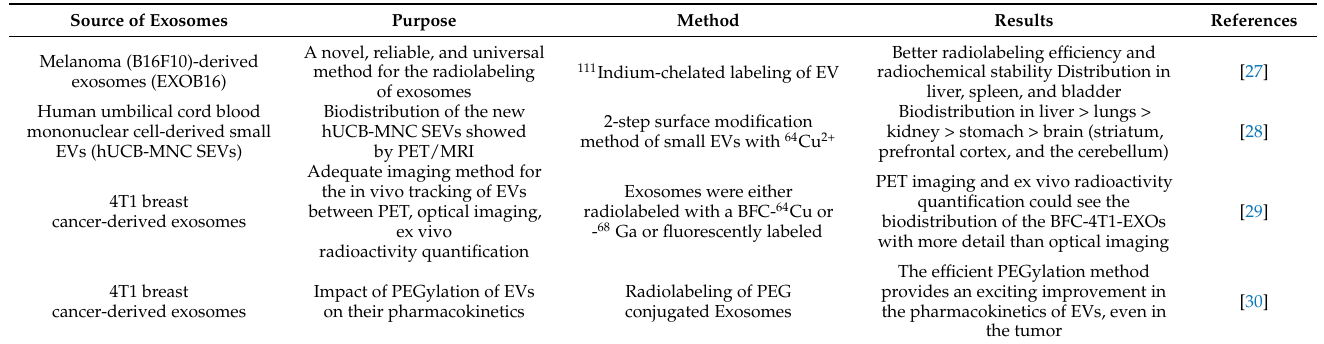
Table 2. Summary of the studies dealing with chemical modification for the in vivo tracking of extracellular vesicles using bifunctional chelators for membrane